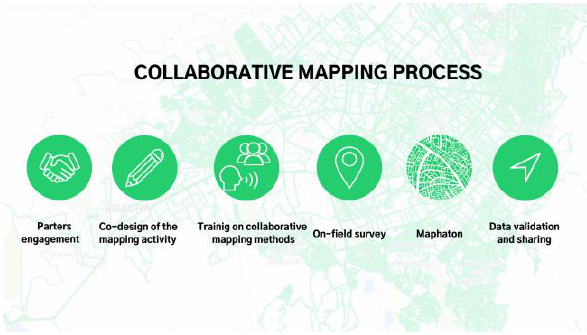
Figure 1 . Collaborating Mapping